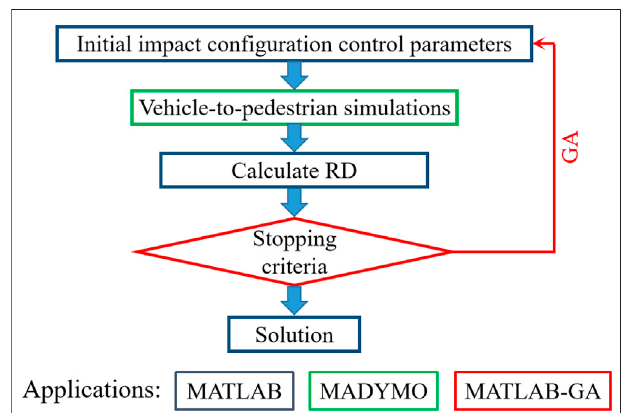
FIGURE 2 | Optimization framework for kinematic reconstruction.